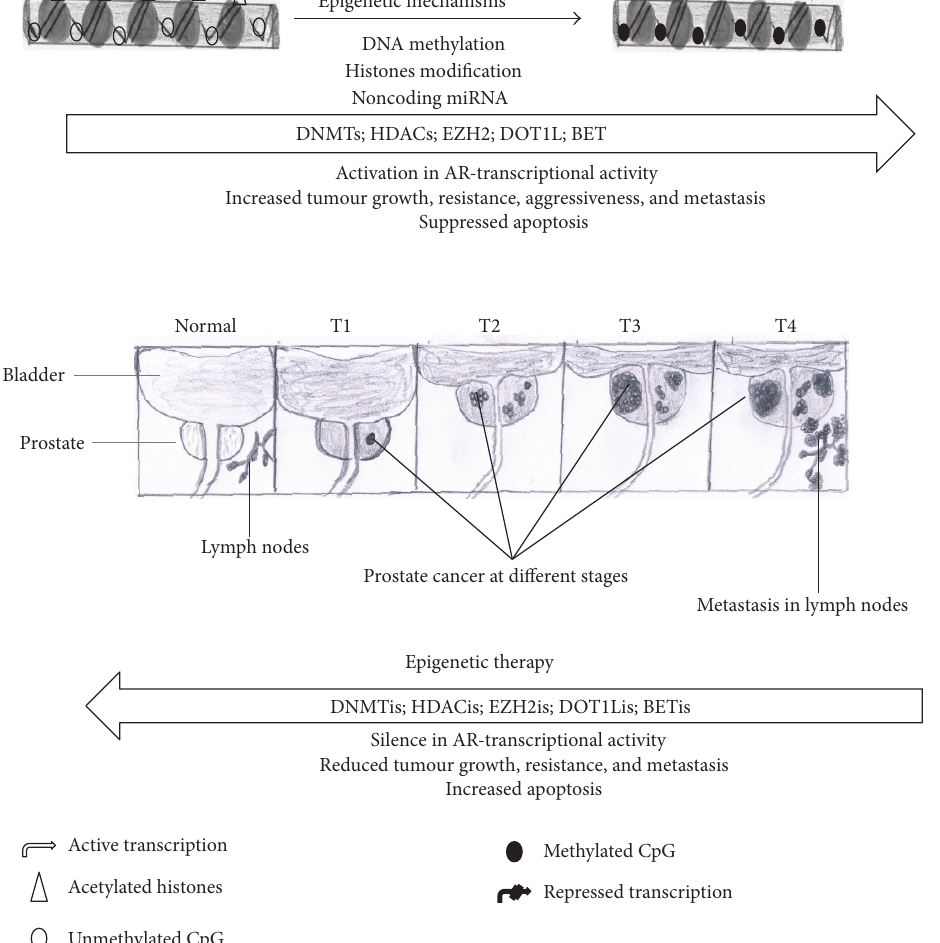
Figure 3: Epigenetic mechanisms and therapy in advanced prostate cancer. Prostate cancer follows aberrant epigenetic alterations that are associated with perturbed cellular processes that are critical in tumorigenesis. In normal cell, CpG islands are protected from DNA methylation and deacetylation whereas a prostate cancer cell is characterised by tumour growth, differentiation, resistance, and metastasis resulting from aberrant DNA methylation and deacetylation. AR: androgen receptor; BET: bromodomain and extraterminal; CpG: cytosine- phosphate-guanine island; DNMTs: DNA methyltransferases; DOT1L: DOT1-like histone H3K79 methyltransferase; EZH2: enhancer of zeste 1; HDACs: histone deacetylases; DNMTs: DNA methyltransferase inhibitors; HDACs: histone deacetylase